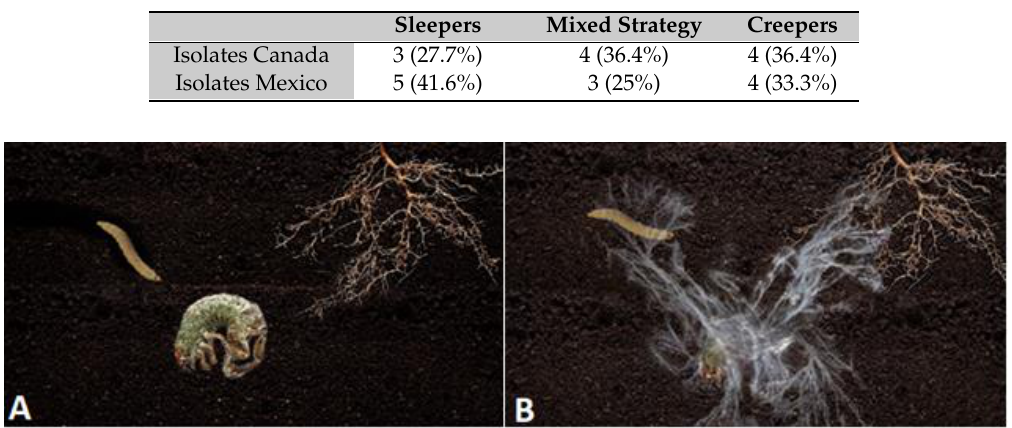
Figure 1. Photos of different morphologies: ( A ) sleepers, ( B ) mixed strategy, and ( C ) creepers of Metarhizium robertsii strains on PDA medium, infected insects, and close-up on infected insects under 16:8 light/dark and complete darkness conditions. Table 1. Percentage of sleepers, creepers, and mixed strategy phenotypes in complete darkness of M. robertsii strains from Mexico and Canada.